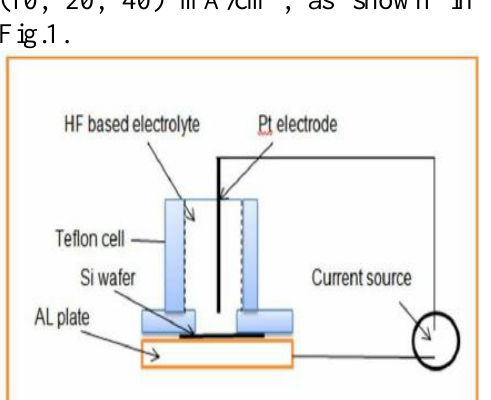
Fig.1: The electrochemical etching set- up.